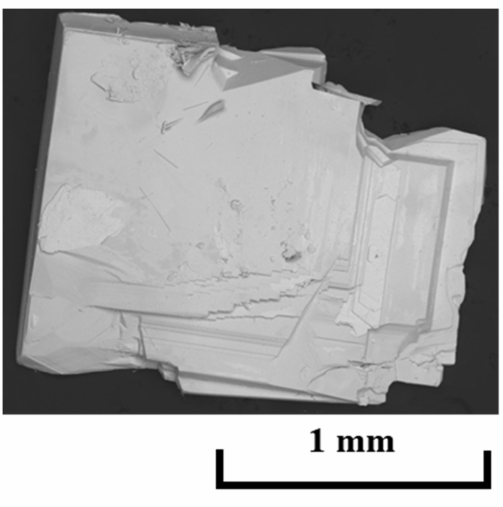
Figure 1. Typical SEM image of a (La,Ce,Pr)OBiS 2 single crystal.